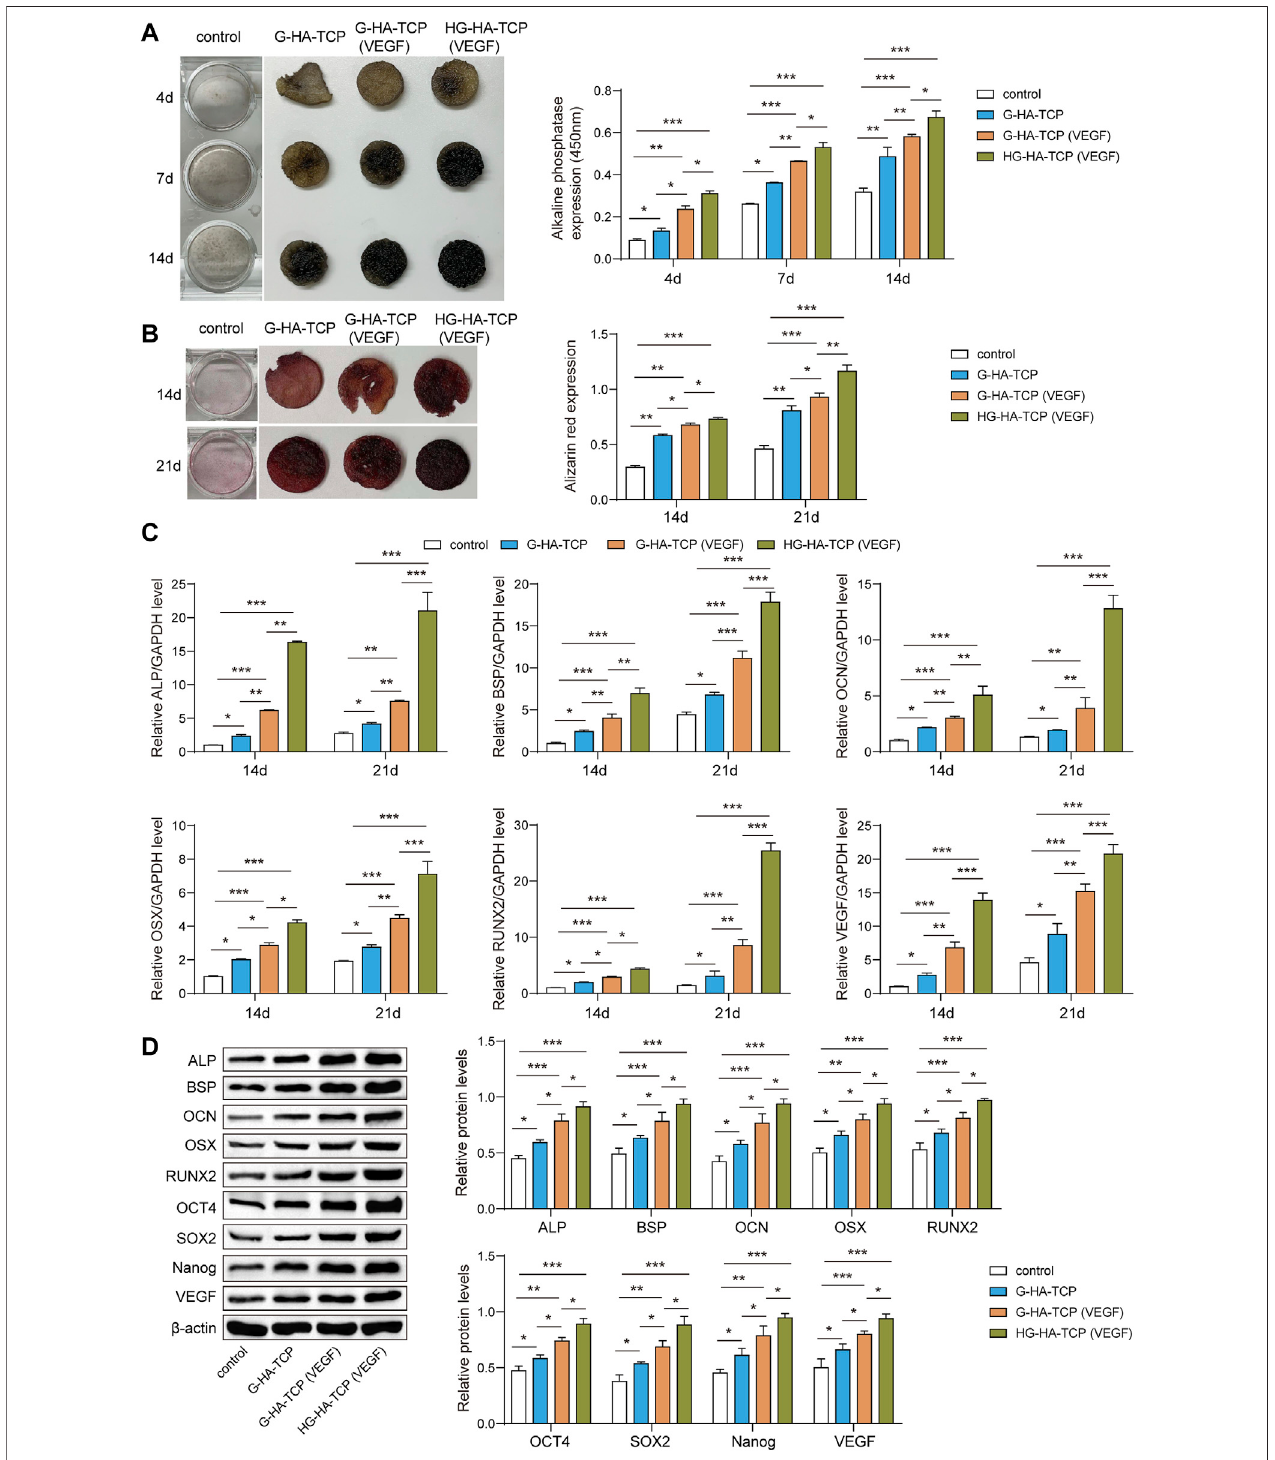
FIGURE 5 | HG-HA-TCP (VEGF) promotes the osteogenic differentiation of SHED. (A) ALP staining was performedto detect cell ALP activity. (B) Alizarin red S staining was performed to measure cell mineralisation. (C) qRT-PCR analysis of mRNA levelsof ALP, BSP, OCN, OSX, RUNX2, and VEGF. (D) Western blot analysis of protein expressions of ALP, BSP, OCN, OSX, RUNX2, OCT4, SOX2, Nanog, and VEGF () n = 3. * p < 0.05, ** p < 0.01, *** p < 0.001.